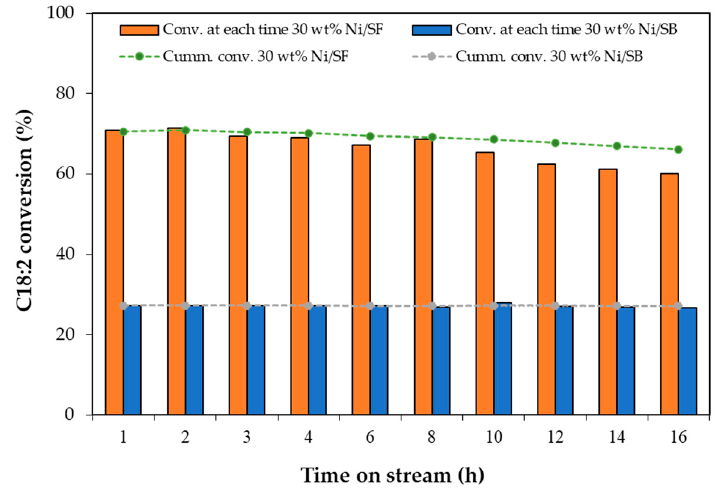
Figure 9. Comparison of catalyst stability in terms of C18:2 conversion at each time on stream and cumulative C18:2 conversion for the 30 wt% Ni / SF and 30 wt% Ni / SB catalysts in the partial hydrogenation of FAME under 1 bar H 2 pressure at 140 °C.